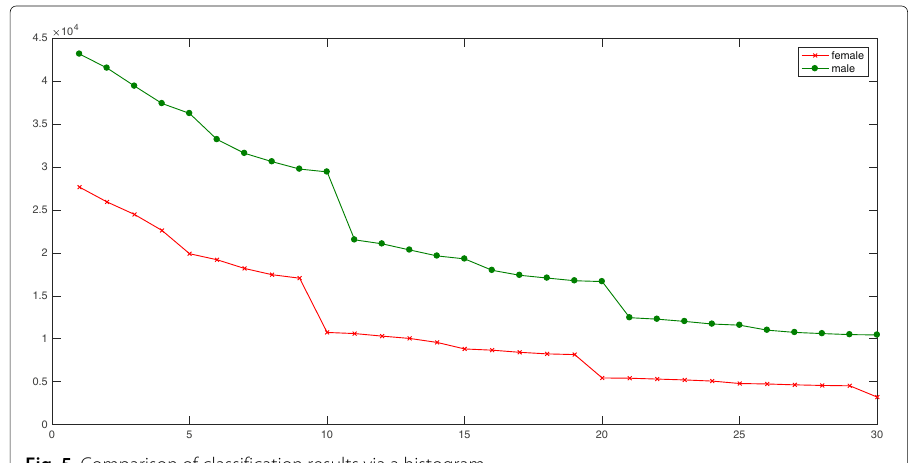
Fig. 5 Comparison of classification results via a histogram